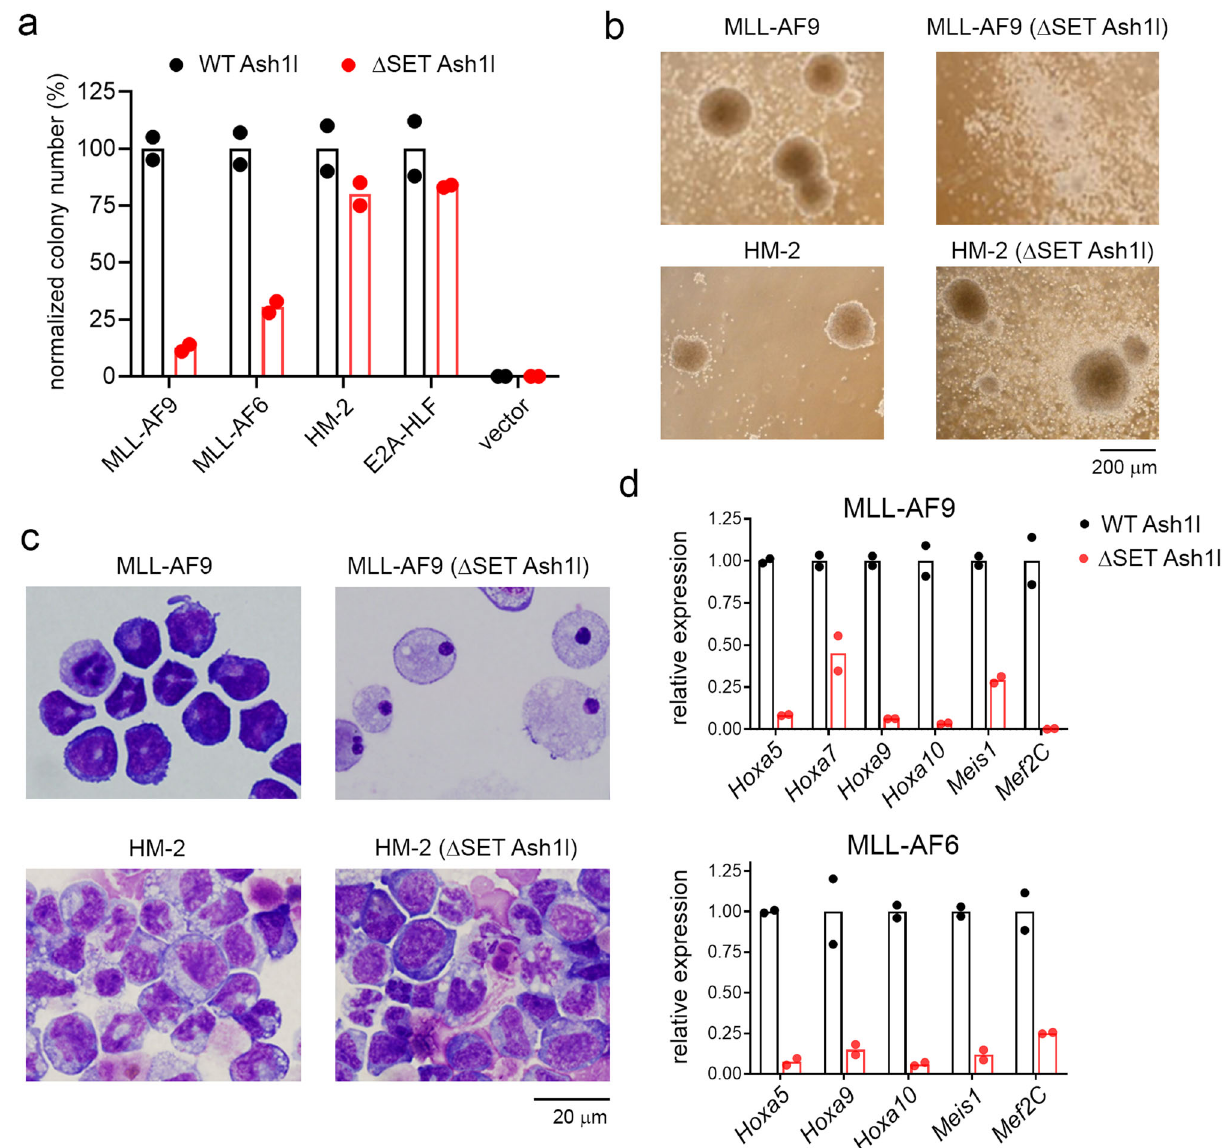
Fig. 1 SET domain of ASH1L is essential for ef fi cient transformation by MLL fusion oncogenes. a Normalized colony counts from the round four of colony-forming assay performed in mouse bone marrow (BM) progenitor cells derived from the WT or Δ SET Ash1l mice and transduced with MLL-AF9 , MLL-AF6 , HOXA9/MEIS1 (HM-2), E2A-HLF or vector alone (MSCV). n = 2. b , c Representative pictures of colonies ( b ) or Wright-Giemsa stained cytospins ( c ) from the round four of colony assay performed in bone marrow cells derived from WT or Δ SET Ash1l mice and transduced with MLL-AF9 or HOXA9/ MEIS1 (HM-2). The experiment was repeated twice with similar results. d Quantitative RT-PCR performed in BM cells derived from WT or Δ SET Ash1l mice and transduced with MLL-AF9 or MLL-AF6 . Gene expression was normalized to Gapdh and gene expression changes in Δ SET Ash1l cells were referenced to the corresponding values in the WT Ash1l background. Data represent two independent experiments each performed in